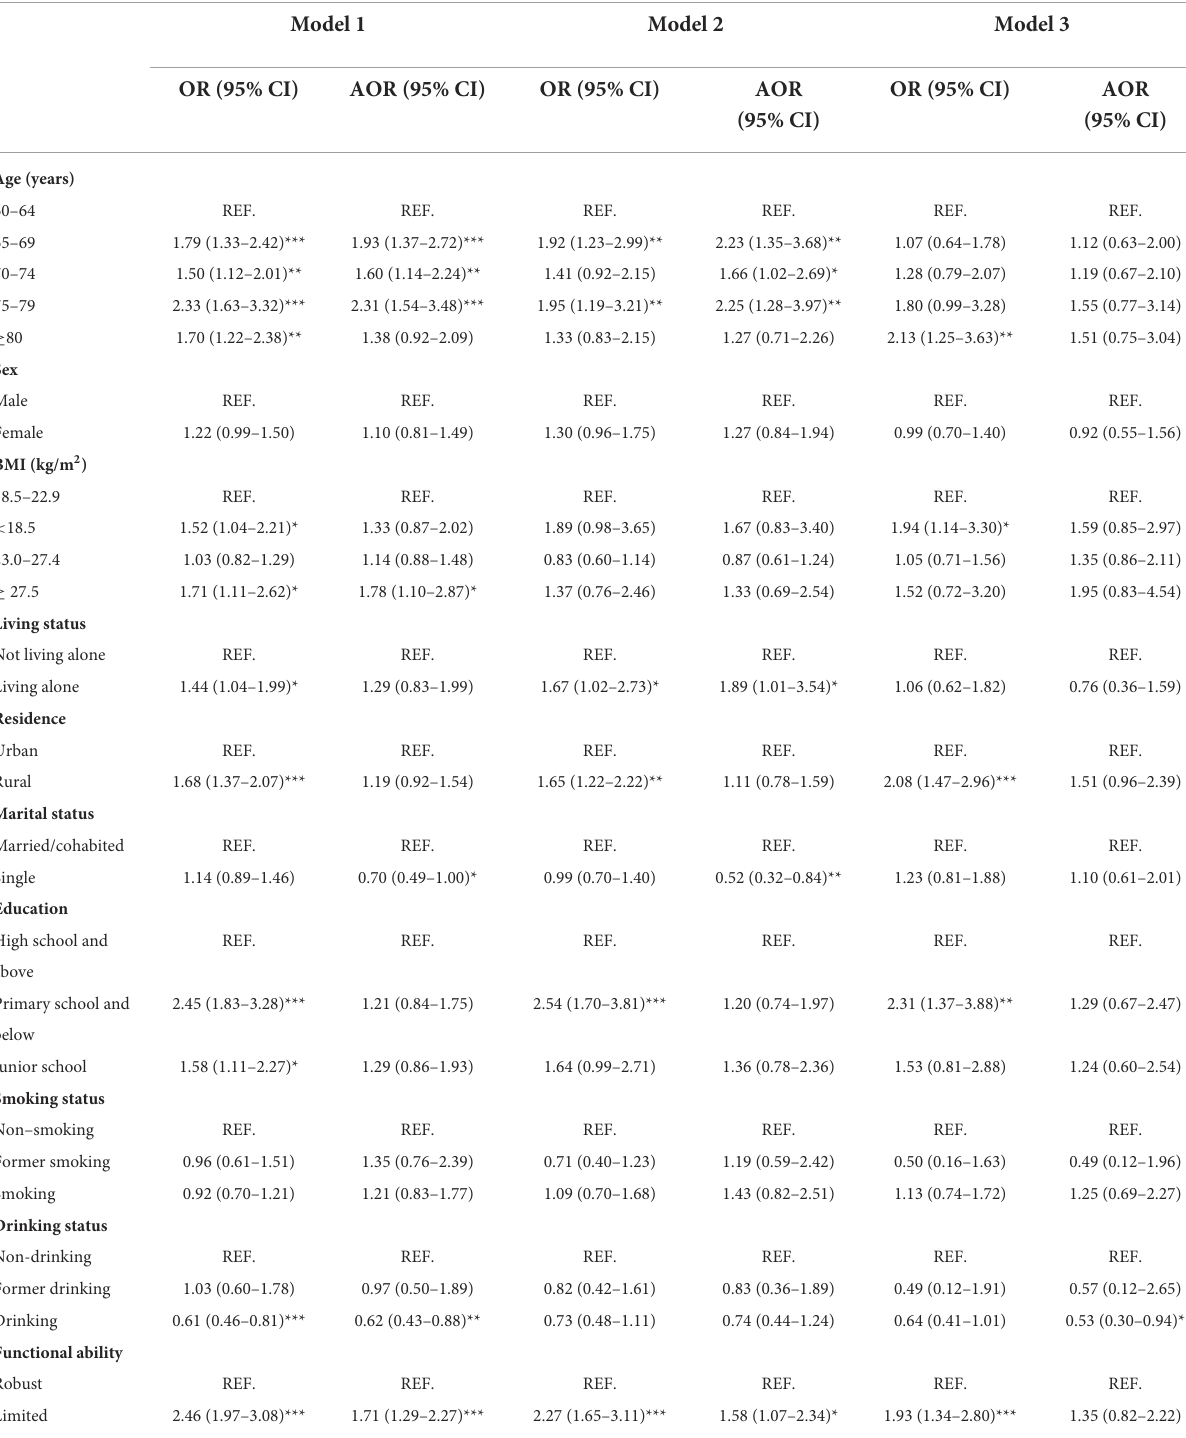
TABLE 2 Results of the odds ratio ( OR ) for developing poor self-rated